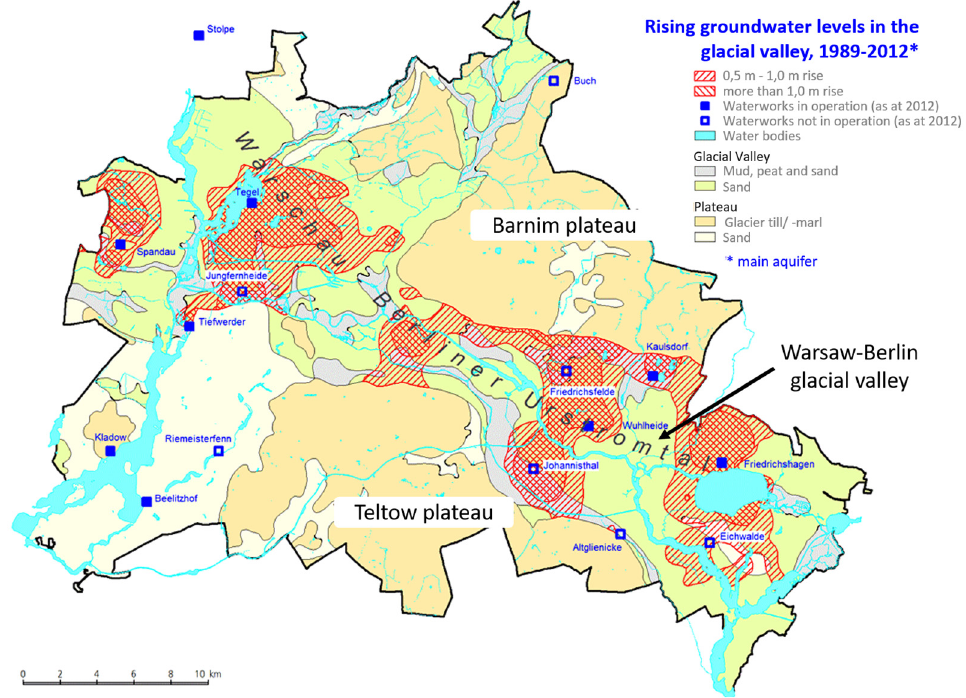
Figure 5. Map of rising groundwater levels in Berlin, 1989–2012 ( adapted from Ref. [8] (p. 12)).